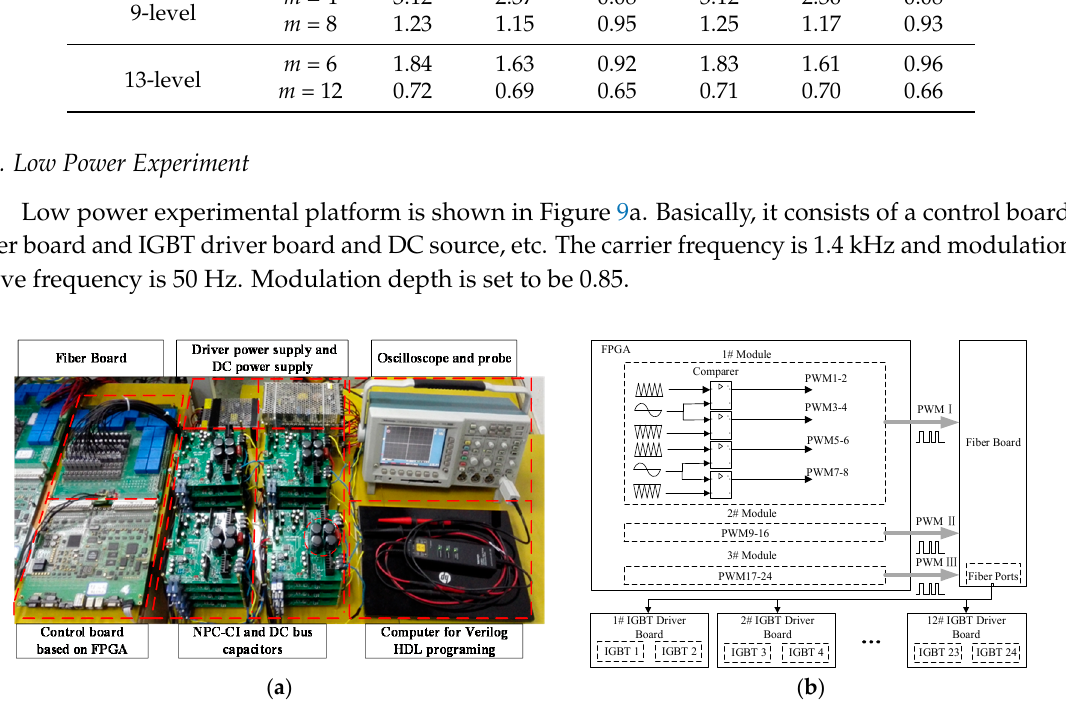
Figure 9. Experimental platform. ( a ) Prototype of Single-phase NPC-CI. ( b ) Control Strategy.